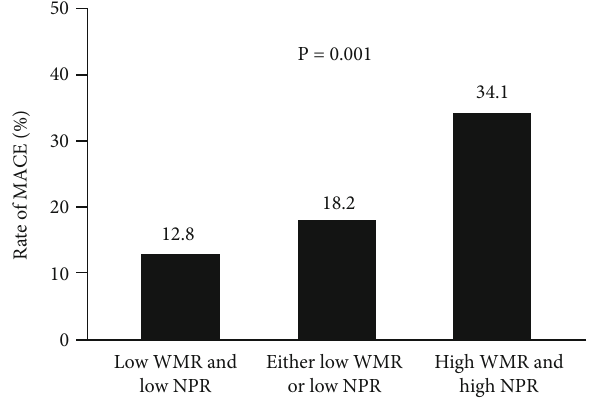
Figure 3: Rate of adverse events in MINOCA patients based on combined WMR and NPR medians. WMR: white blood cell count to mean platelet volume ratio; NPR: neutrophil-to-platelet ratio; MACE: major adverse cardiovascular events.